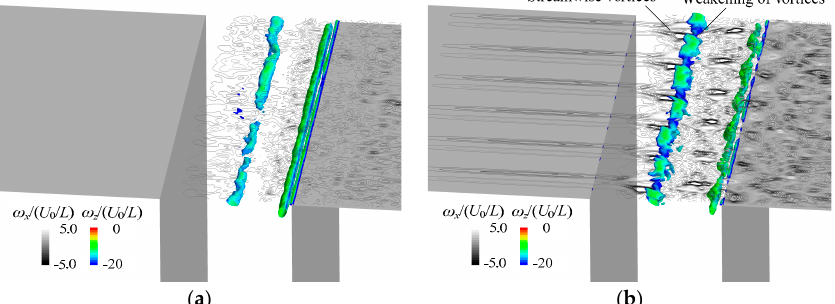
Figure 16. Iso-surfaces of the component of the second invariant related to vortices with a spanwise axis q z /( U 0 / L ) 2 = − 20 color-coded by the spanwise vorticity, together with contours of the streamwise vorticity in the shear layer ( y / θ = 2.9) at the phase where the vortex collides with the downstream edge of the cavity: ( a ) baseline flow; and ( b ) controlled flow.